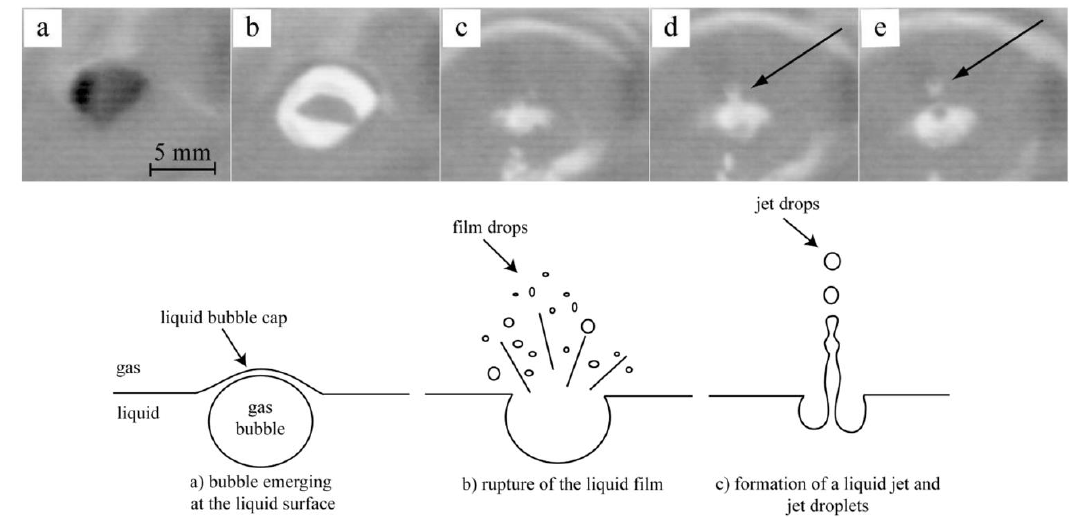
Figure 11. Top: frames taken from a high-speed video (emergence of a bubble ( a , b ), disruption of the bubble cap ( c ), formation of vertical liquid jet ( d ), emission of a drop from the jet ( e )); Bottom: bubble burst mechanism for dust generation [36]